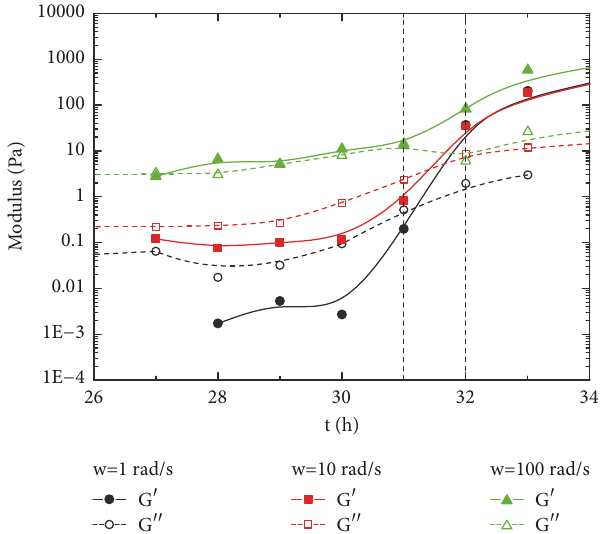
Figure 3: Elastic (solid symbols) and viscous (hollow symbols) moduli measured at frequencies of 1 rad/s (black circles), 10 rad/s (red squares), and 100 rad/s (green triangles) as a function of time. Lines are guides to the eye. Dashed vertical lines indicate the time interval where the crossover of G’-G”